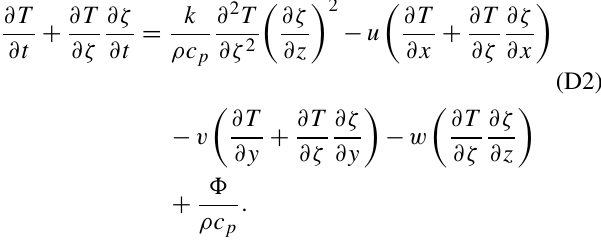
Figure C1. By combining the regular (black) and staggered (red) vertices into a single mesh, each staggered vertex has six direct neighbours, so that neighbour functions for both the first and second derivatives can be calculated, using the approach from Appendix